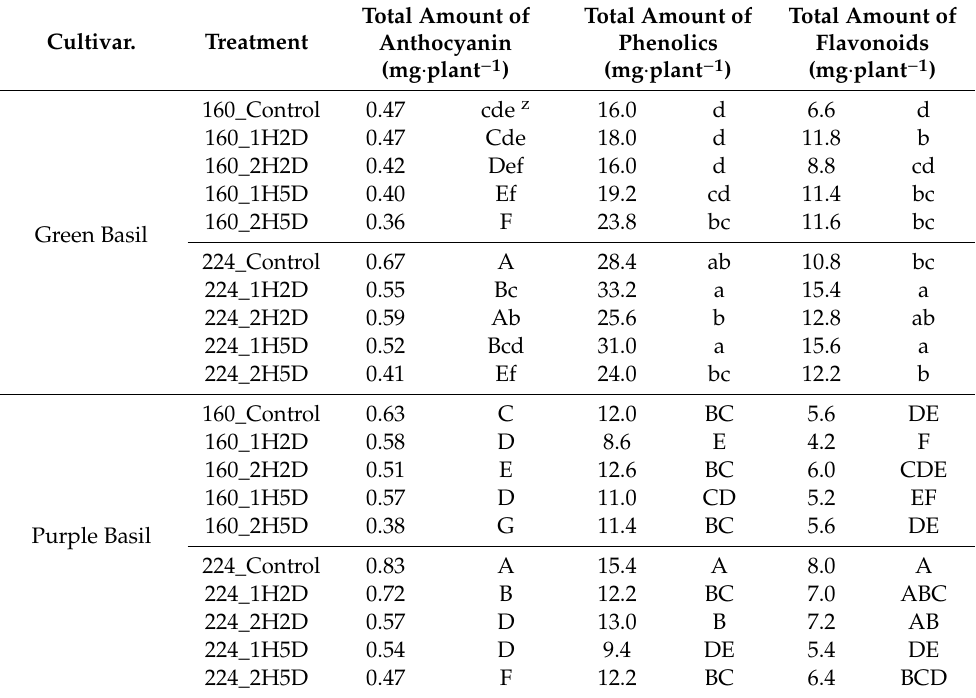
Table 4. Total amount of anthocyanin, phenolics, and flavonoids per plant of green basil ‘Improved Genovese Compact’ and purple basil ‘Red Rubin’ plants under di ff erent treatments. There were 10 treatments created by the combination of two photosynthetic photon flux density (PPFD) of 160 and